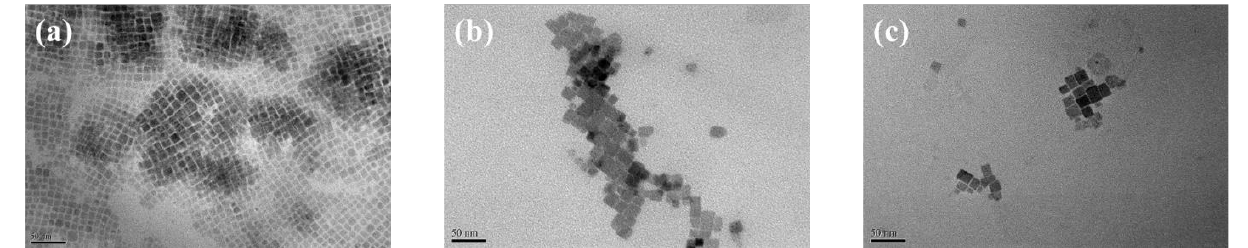
Figure 4. TEM images of ( a ) Agg-1, ( b ) Agg-2, and ( c ) Agg-3 samples.